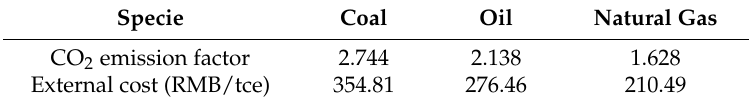
Table 3. CO 2 emission factors for various energy sources and external emission costs.